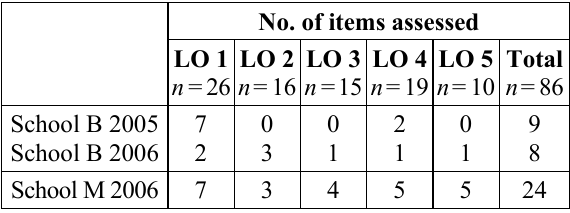
Table 1: Learning outcomes and assessment